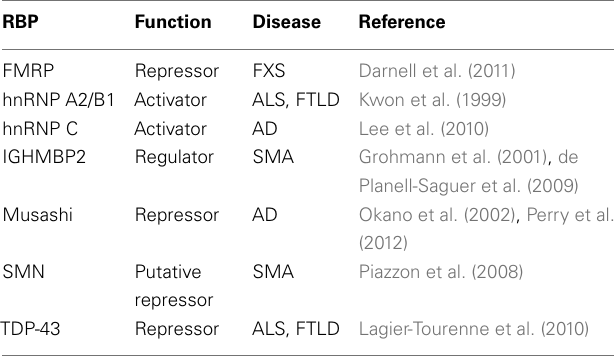
Table 2 | List of RBPs involved in translation and implicated in neurological